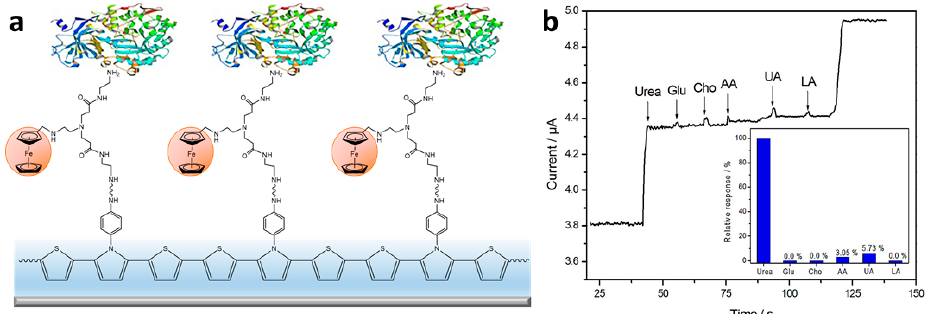
Figure 9. ( a ) Biosensing electrode with immobilized urease. ( b ) Interferents glucose (Glu), cholesterol (Cho), ascorbic acid (AA), uric acid (UA), and lactic acid (LA) have minimal amperometric response relative to urea [44]. Reprinted from Enzyme and Microbial Technology , Vol. 102, M. Dervisevic, E.